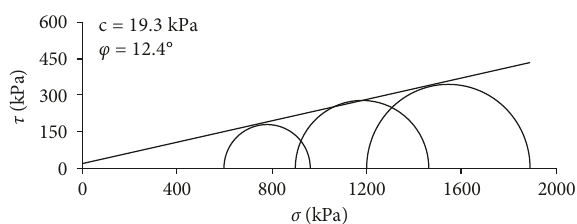
Figure 9: The total stress strength of the disturbed sample in high- stress triaxial test.